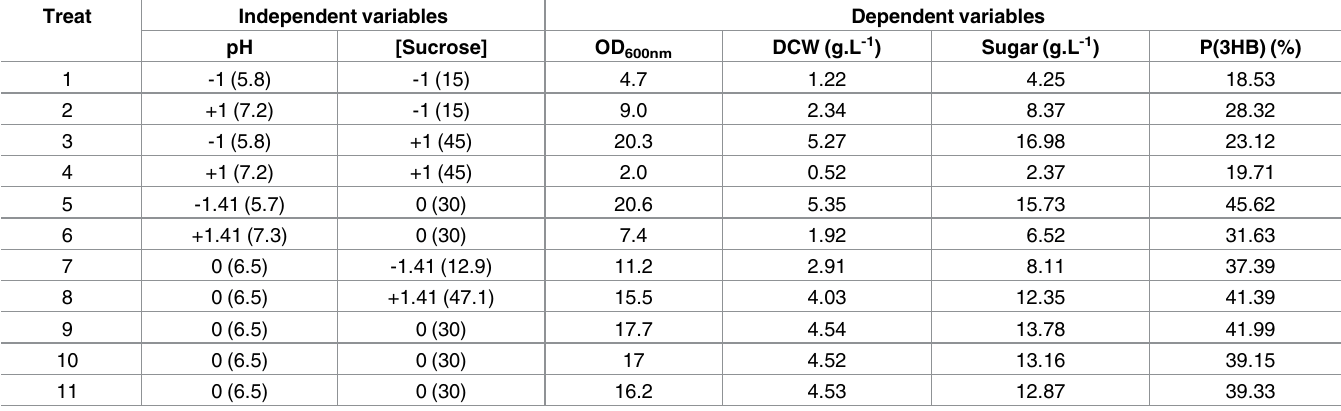
Table 2. Matrix of the experimental planning CCRD 2 2 . Coded and real levels as well as values of the responsevariablesobtainedfor R . solanacearum RS inoculumincubatedat 32˚C and 250 rpm for 24 h and YM culture medium with sucrose as the carbonsource.